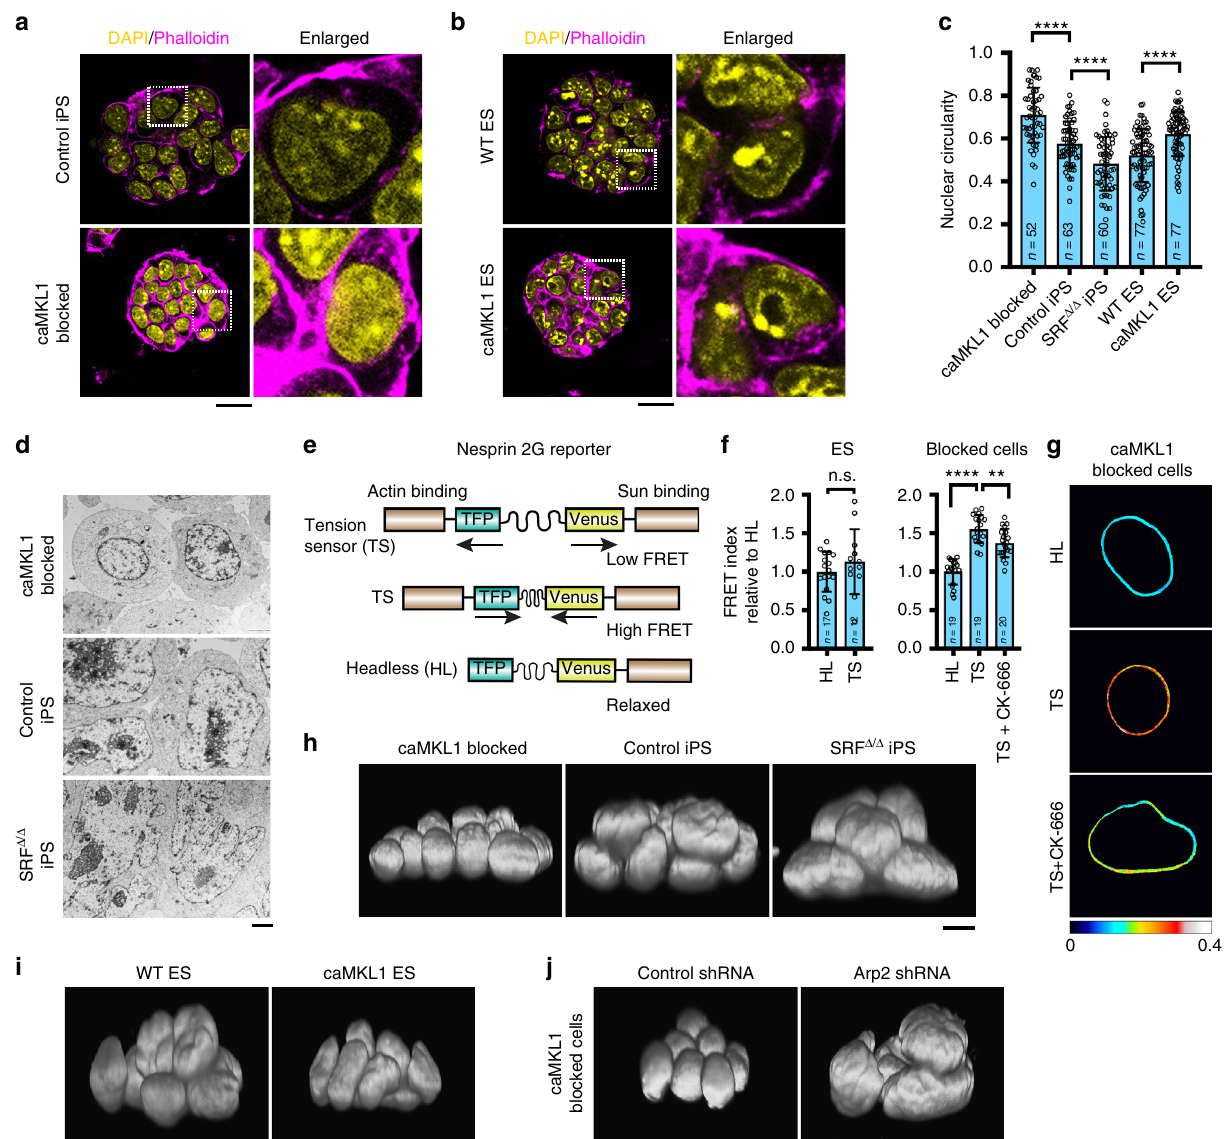
Fig. 5 MKL1-actin pathway regulates nuclear volume. a , b DAPI and phalloidin staining in control iPS cells and caMKL1-blocked cells ( a ); WT and caMKL1- overexpressing ES cells ( b ). Rectangular boxes indicate regions shown at higher magni fi cation on right. Scale bar: 20 μ m. c Nuclear circularity of indicated cell types. The numbers of analyzed nuclei are as indicated. **** P < 0.0001. d Electron microscopy images showing nuclear morphology in